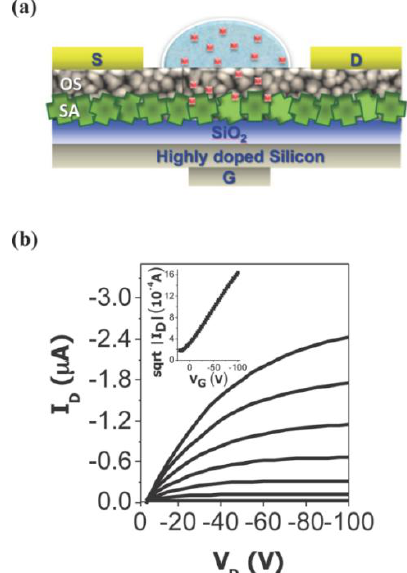
Figure 4. ( a ) Cross-sectional diagram of functional bio-interlayer (FBI)-OFET with a streptavidin layer for the detection of biotin; ( b ) the output characteristic of the biotin-sensing FBI-OFET. Reproduced from